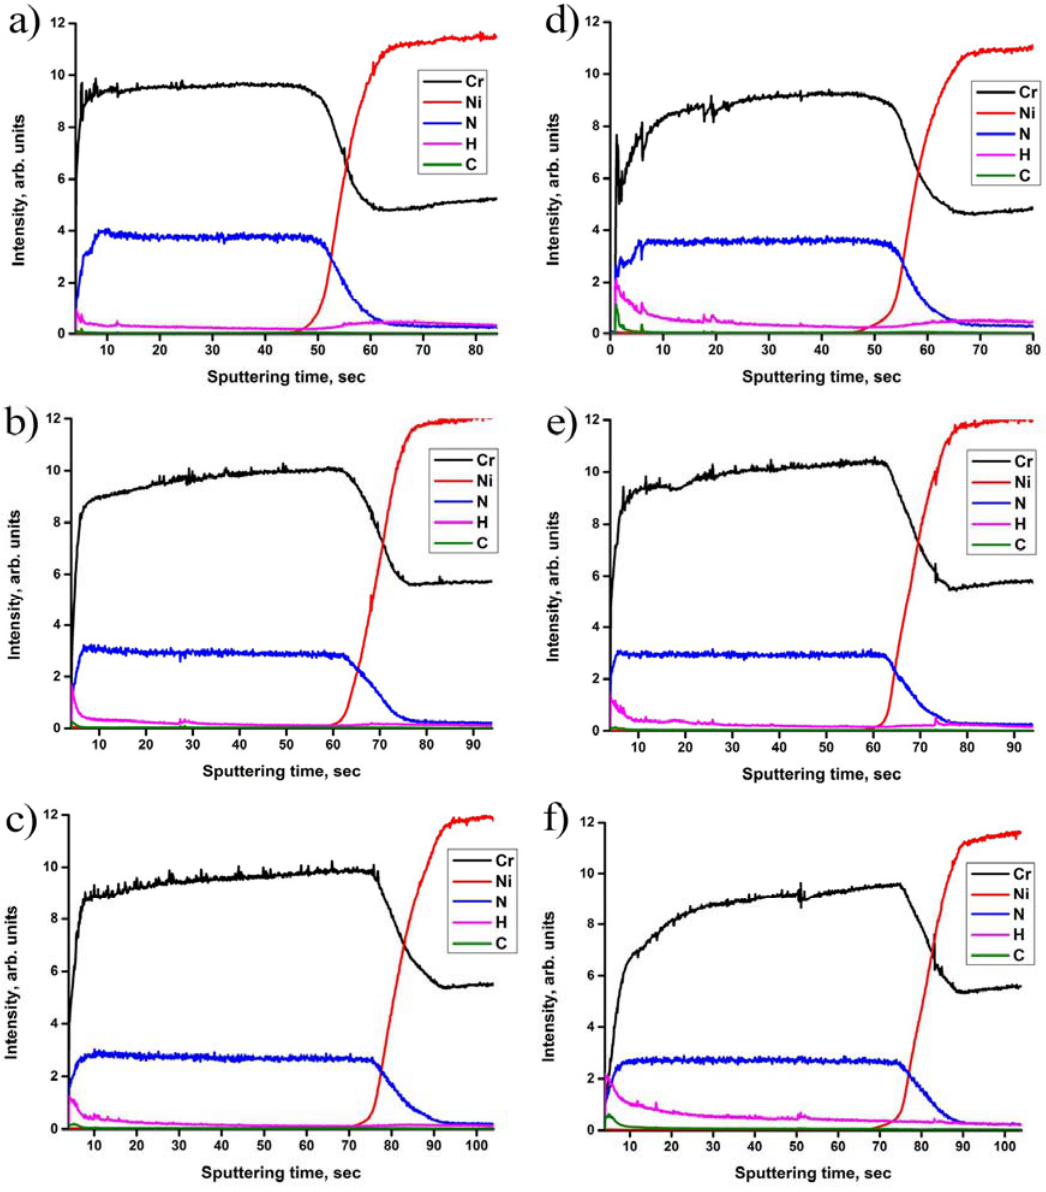
Figure 4. GDOES profiles of elements at ( a ) 300 mPa; ( b ) 600 mPa; ( c ) 900 mPa as ‐ deposited; and ( d ) 300 mPa; ( e ) 600 mPa; ( f ) 900 mPa hydrogen exposed CrxN coatings on the IN718